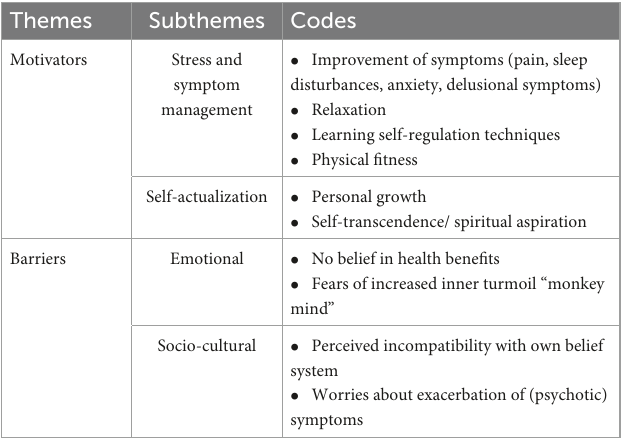
TABLE 5 Motivators and barriers reported at baseline (T 0